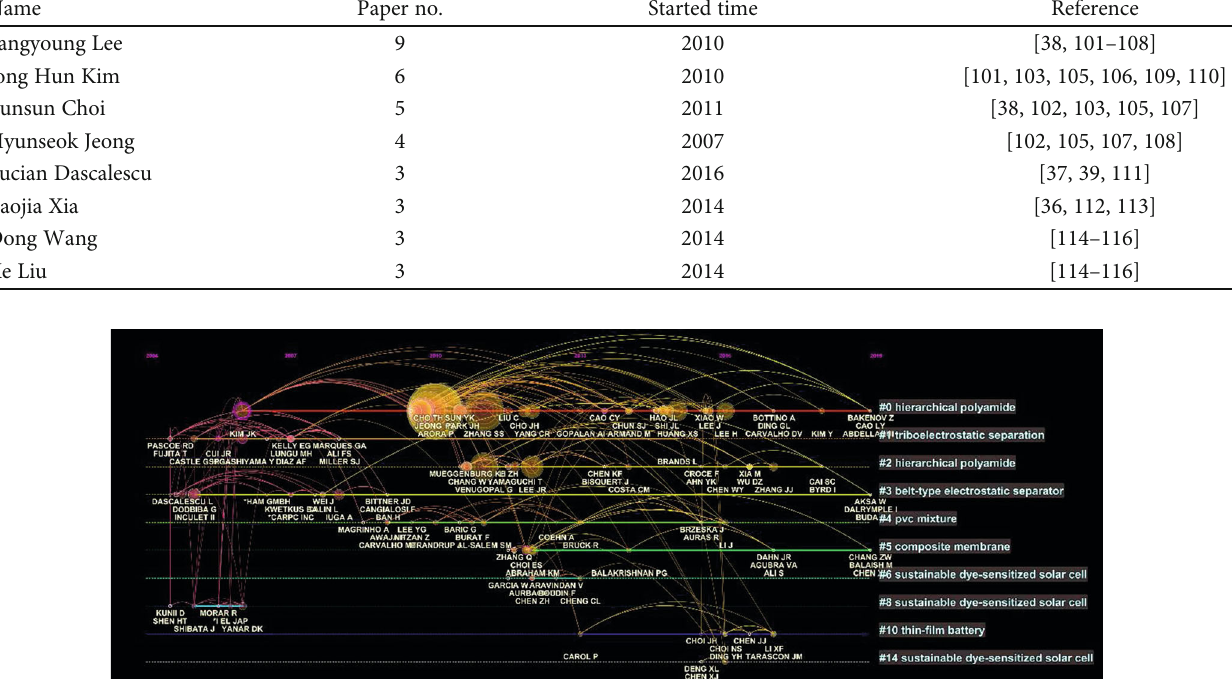
Table 2: Top eight authors with the most published papers.